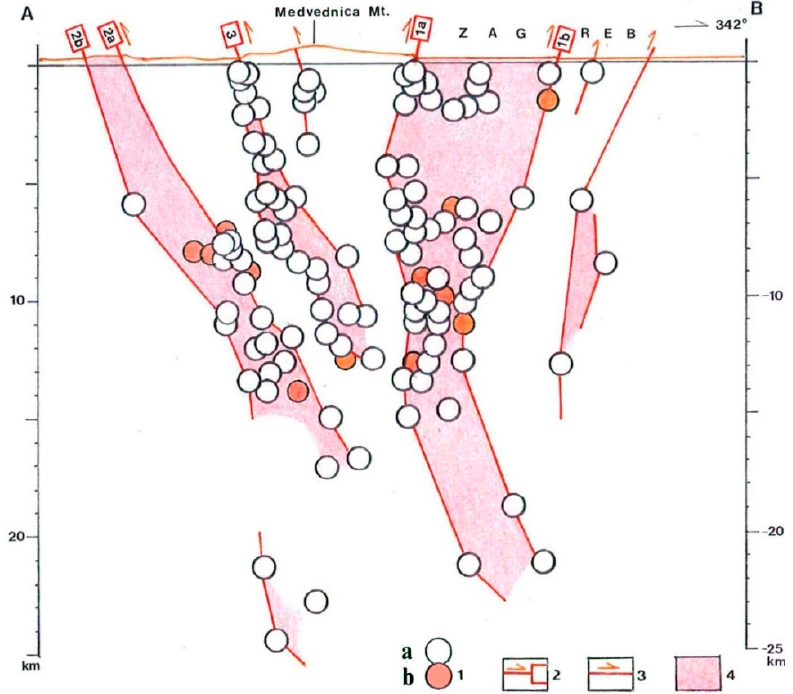
Figure 3. Seismotectonic profile (A–B in Figure 2). 1a —Outbreaks of earthquakes that occurred in the period 1997–2009 with a magnitude of up to 3.5; 1b —in the period 2009–2015 with a magnitude of up to 3.2; 2 —The most important faults in the bordering structural unit Žumberaˇcka gora-Medvednica: Zagreb fault (1), Brežice-Koprivnica fault (2) and Bistra-Laz fault (3); 3 —Other active faults; 4 —Seismotectonically active zone in space (updated from [4]).